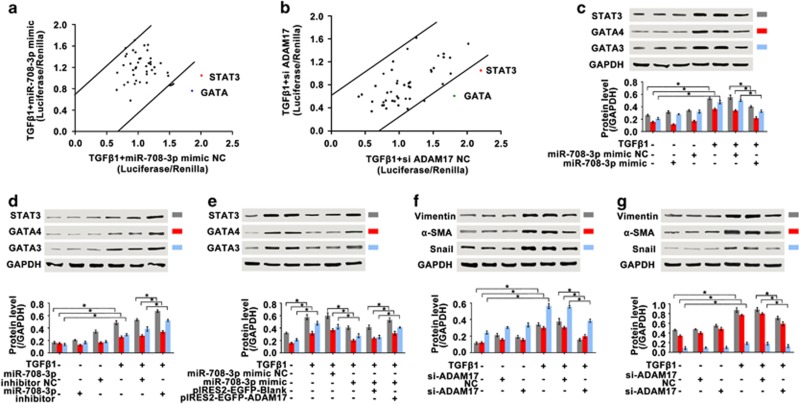
Regulation of miR-708-3p in the IPF-associated aberrant signaling pathways. (a) Identification of signaling pathways affected by the miR-708-3p mimic in MRC-5 cells. The x and y axes represent the normalized ratio of firefly/Renilla luciferase activities, respectively. Most of the significant changes were observed in the STAT3 and GATA signaling pathways. (b) Identification of signaling pathways affected by siADAM17 in MRC-5 cells. The x and y axes represent the normalized ratio of firefly/Renilla luciferase activities, respectively. Most of the significant changes were observed in the STAT3 and GATA signaling pathways. (c) The miR-708-3p mimic inhibited the expression levels of GATA3, GATA4 and STAT3 proteins in A549 cells. (d) The miR-708-3p inhibitor promoted the expression levels of GATA3, GATA4 and STAT3 proteins in A549 cells. (e) Rescue experiments (miR-708-3p mimic+ADAM17 overexpression) further confirmed miR-708-3p regulation in the IPF-associated aberrant STAT3/GATA signaling pathways in MRC-5 cells. (f) SiADAM17 blocked the expression of GATA3, GATA4 and STAT3 in A549 cells. (g) SiADAM17 blocked the α-SMA, vimentin and Snail expression in MRC-5 cells. Each bar represents the mean±s.d.; n=6, *P<0.05.